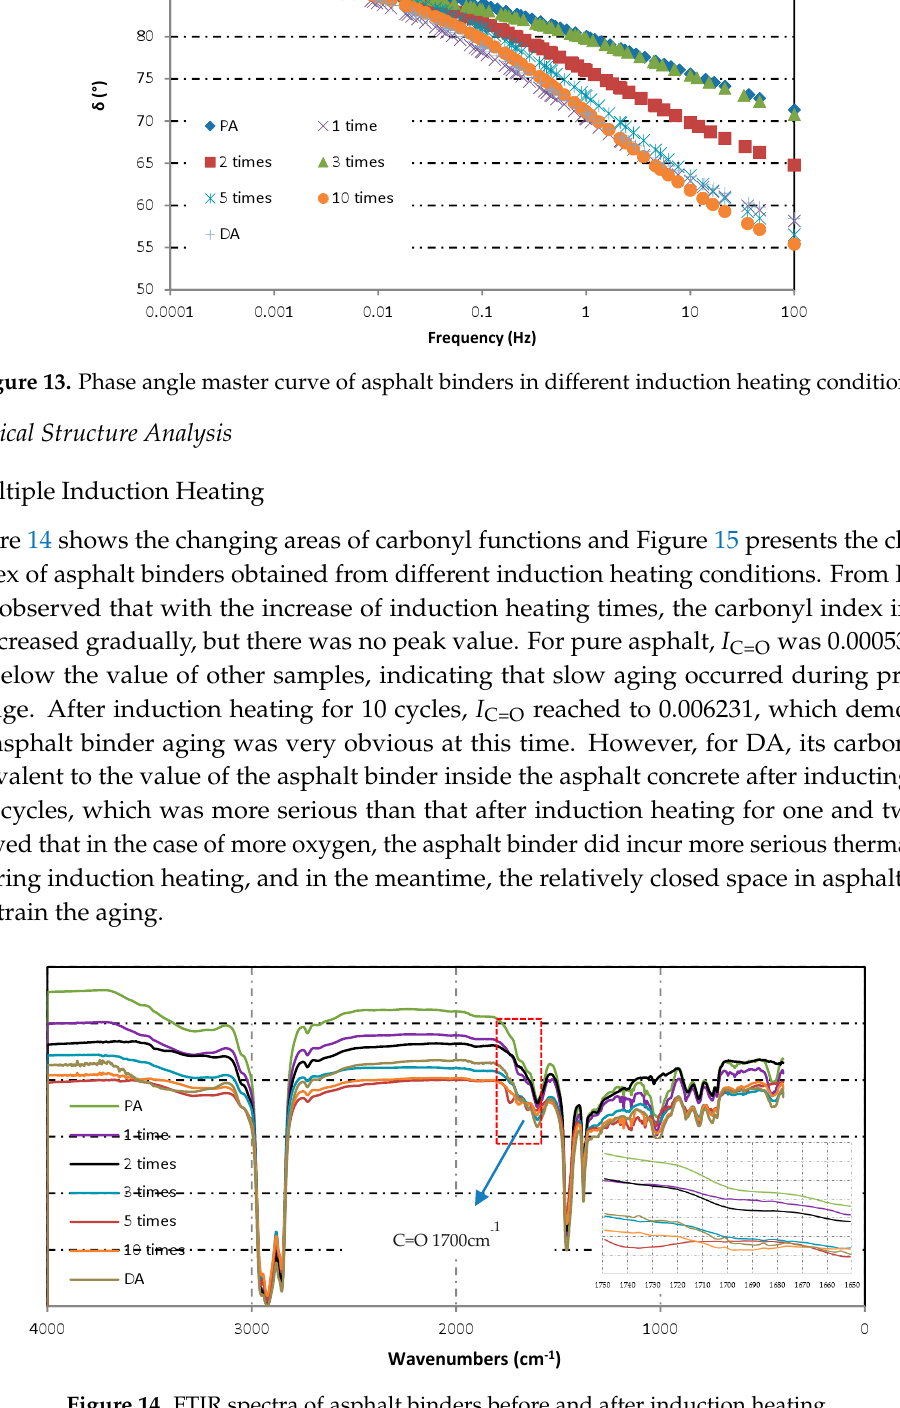
Figure 12. Complex modulus master curve of asphalt binders in different induction heating conditions.